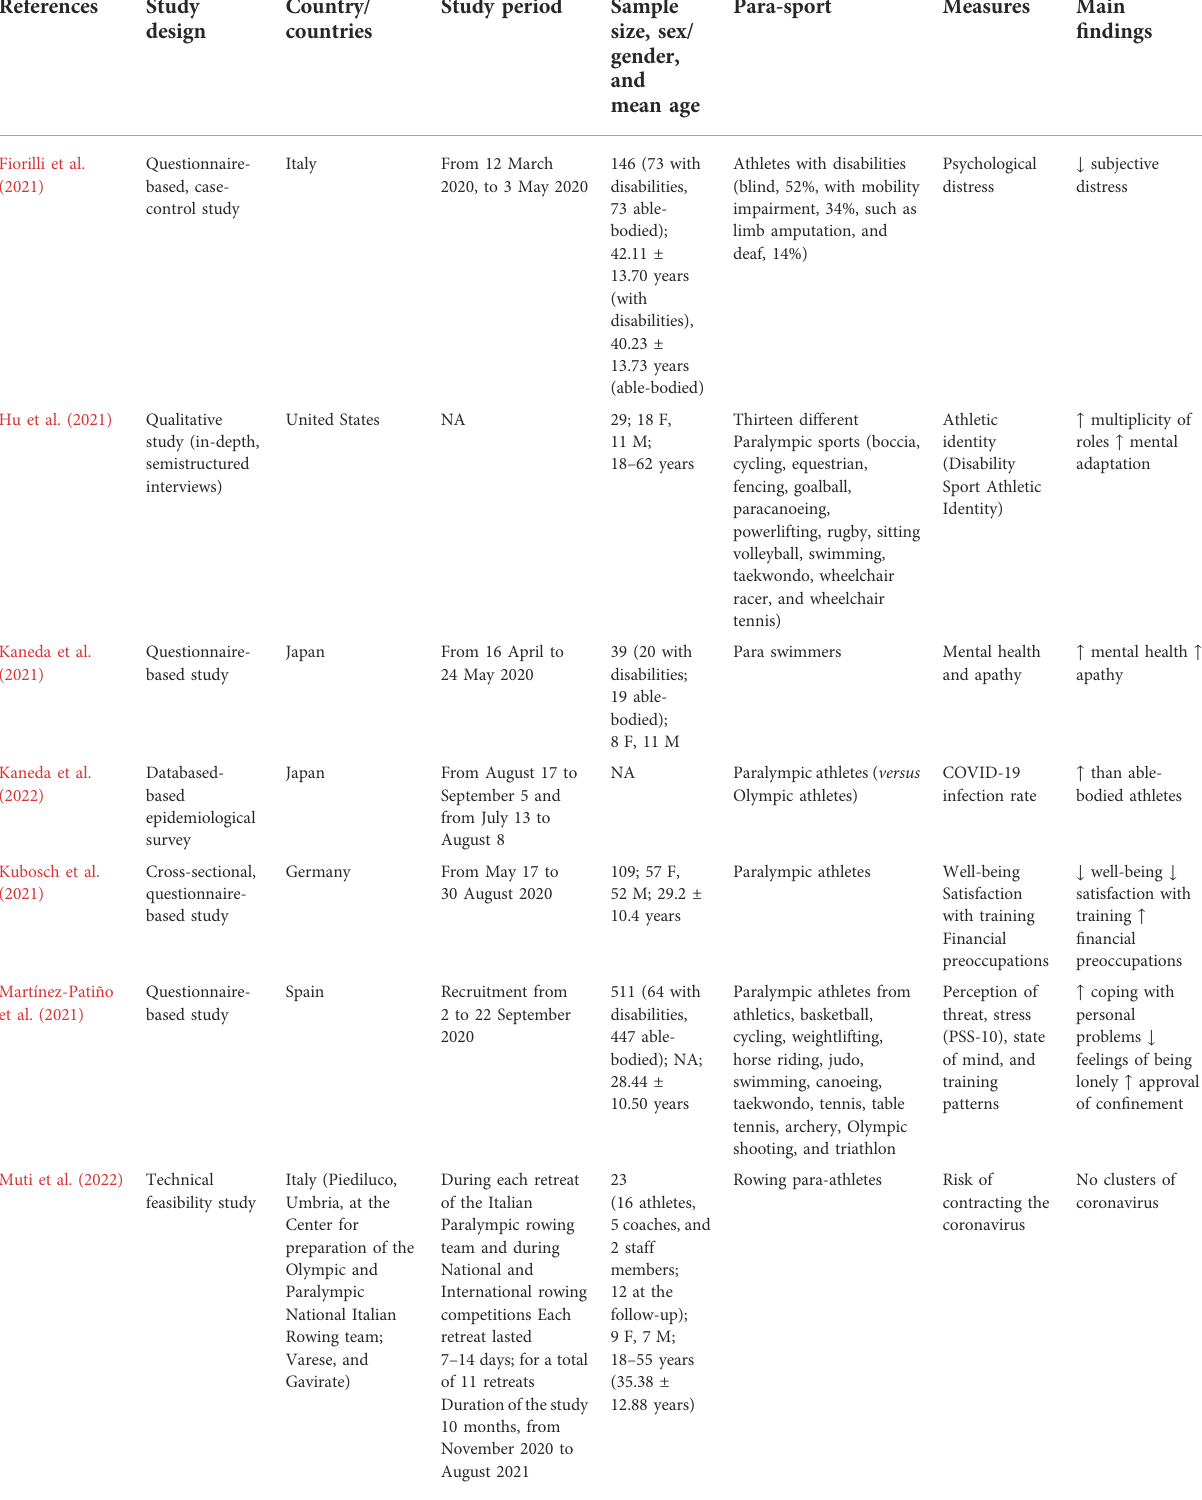
TABLE 2 ( Continued ) Main features of included studies. Abbreviations: BFPI, Big Five Personality Inventory; CAS, coronavirus anxiety; CMJ, countermovement jump; FFQ, Food Frequency Questionnaire; MAT, modi fi ed agility t -test; NA, not available; 1RM, one repetition maximum;